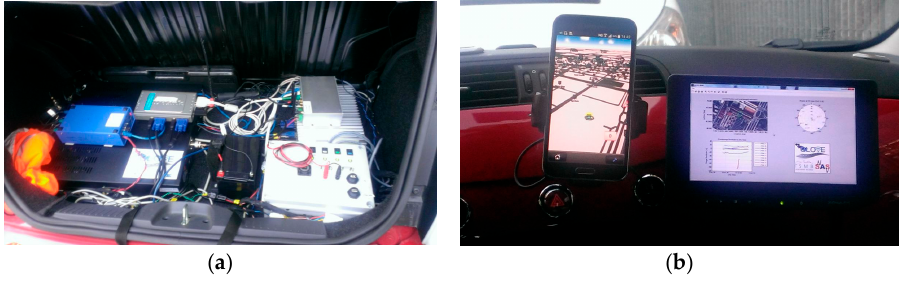
Figure 12. Local integrity demonstrator integrated in the vehicular prototype: ( a ) Car PC mounted in the trunk. ( b ) On-board data display. Reproduced with permission from [12].